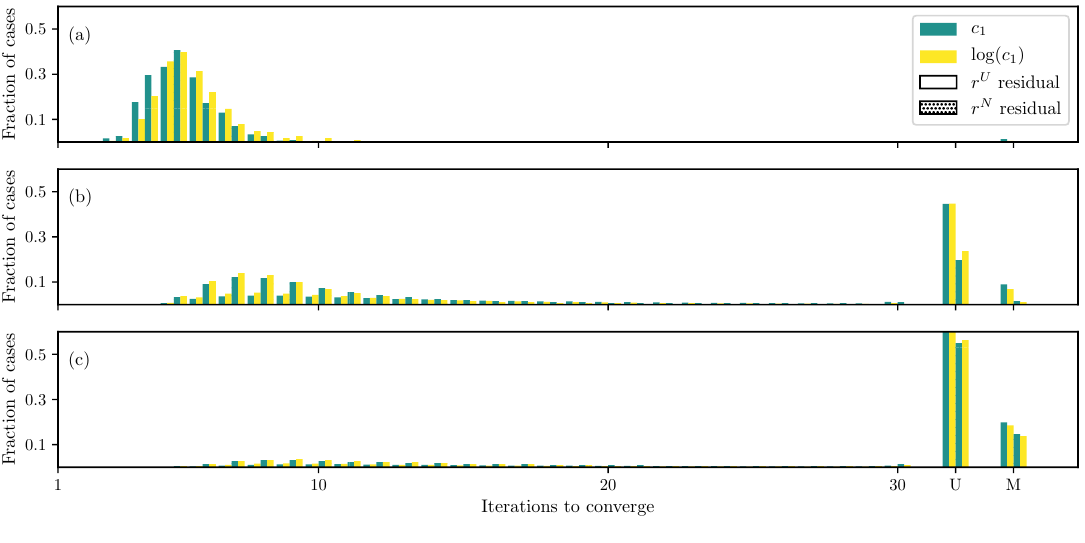
Figure 6. Iterations required using different formulations for the Lee–Sacks model DC case when ( a ) only c 1 and c 2 are unknown, ( b ) all parameters except the fiber angle θ are unknown, and ( c ) all parameters are unknown.